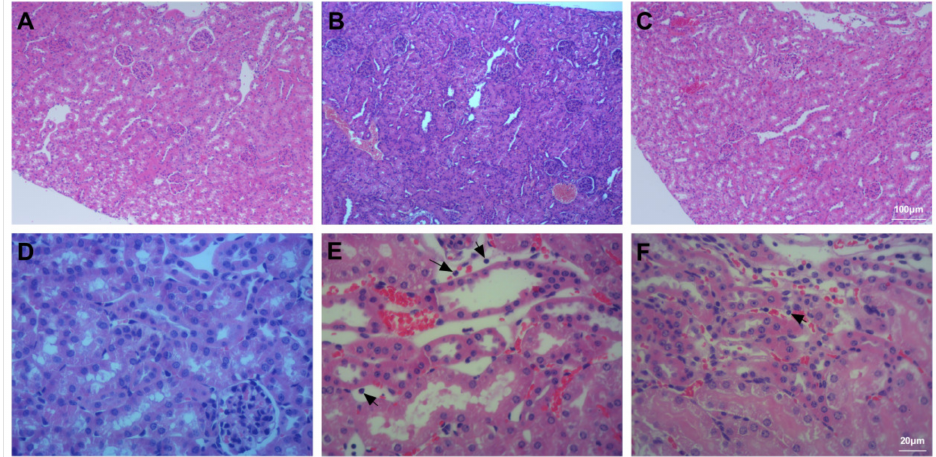
Figure 8. Histological assessment of the kidney tissue: ( A ) Con group; ( B ) Bl group; ( C ) Bl + MSC group; ( D ) Con group; ( E ) Bl group; ( F ) Bl + MSC group. Black arrows indicate neutrophils ( A – C , 100 × magnification; D – F , 400 ×